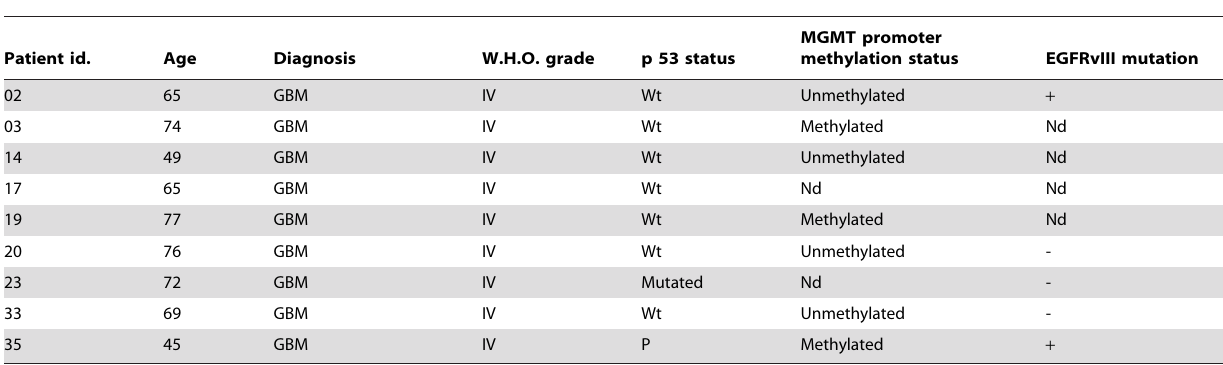
Table 1. Patient characteristics.